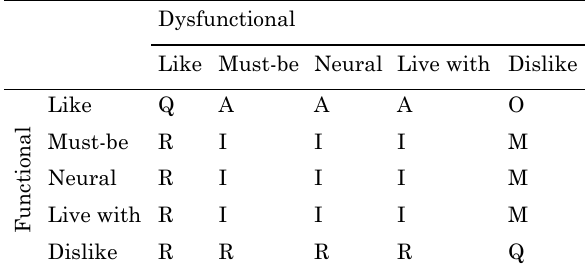
Table 2. Kano evaluation table (Berger et al. 1993)